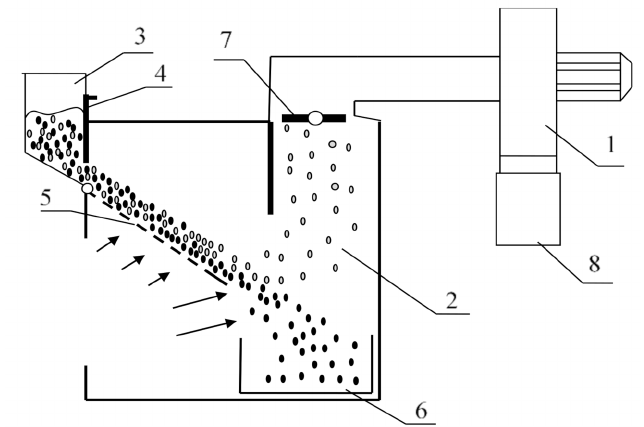
Figure 2. Scheme of unit for research of purification process of preliminarily stratified grain mixture: 1—fan; 2—the pneumo-separation duct; d—loading hopper; 4—the adjustable damper; 5—the scaled air surface; 6—the receiver of the main grain (purified); 7—airflow rate controller; 8—lightweight impurity filter-receiver.